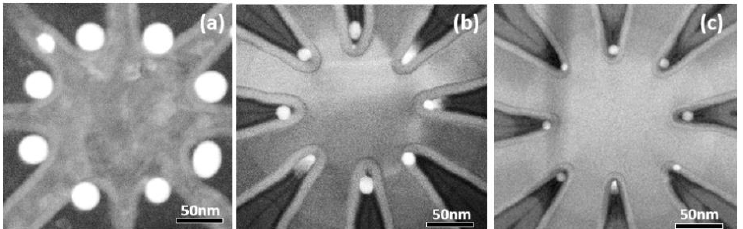
Figure 4. Plan-view STEM observations of ( a ) 30 nm; ( b ) 15 nm; and ( c ) 8 nm Ge octuple QDs fabricated at the sidewall corner of each included angle location for the Si 3 N 4 /asterisk-shaped c-Si showing exquisite control of the number and sizes of the QDs.